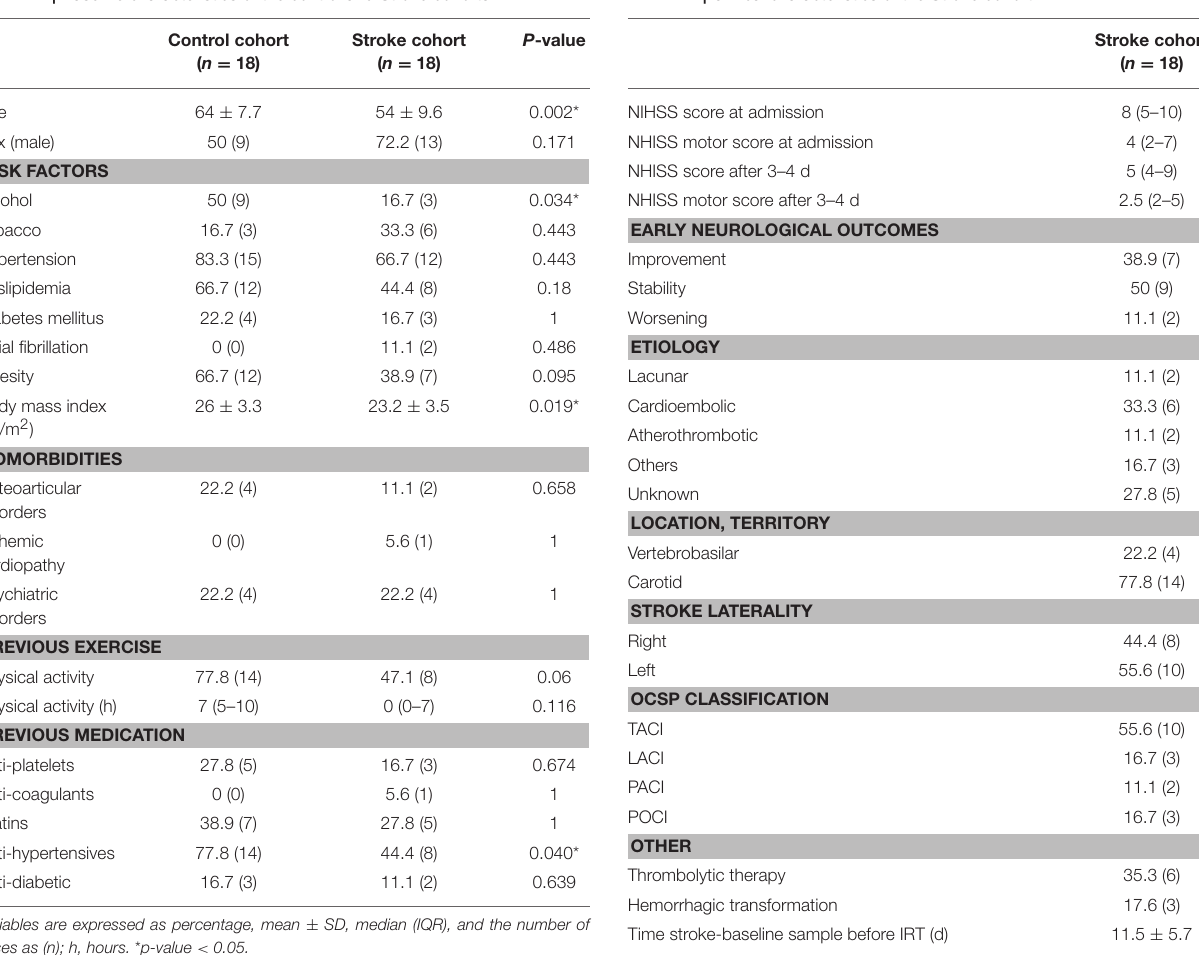
TABLE 1 | Baseline characteristics of the control and Stroke cohorts. TABLE 2 | Clinical characteristics of the Stroke